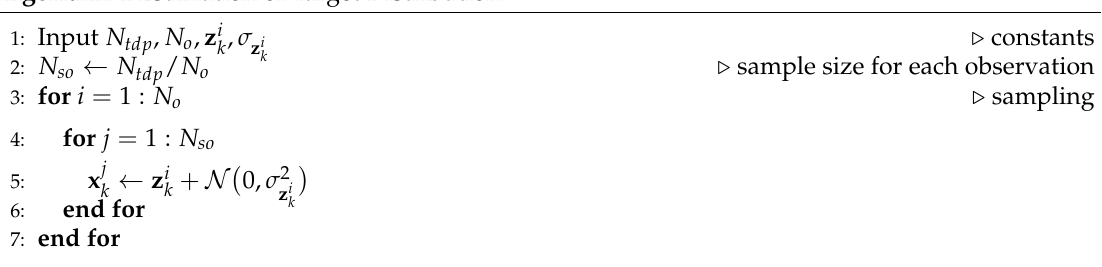
Algorithm 1 Estimation of Target